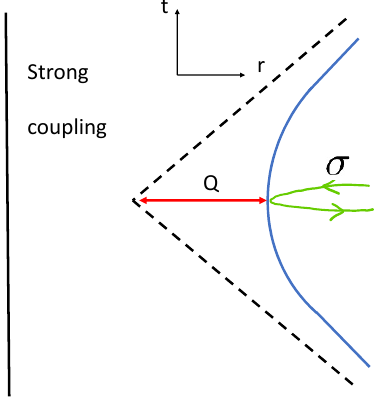
Figure 1 . The shape of the long folded string of [11]. The green line indicates the way the string folds which is always towards the weak coupling region. At early and late times the tip of the string is moving at a speed that approaches (cid:6)